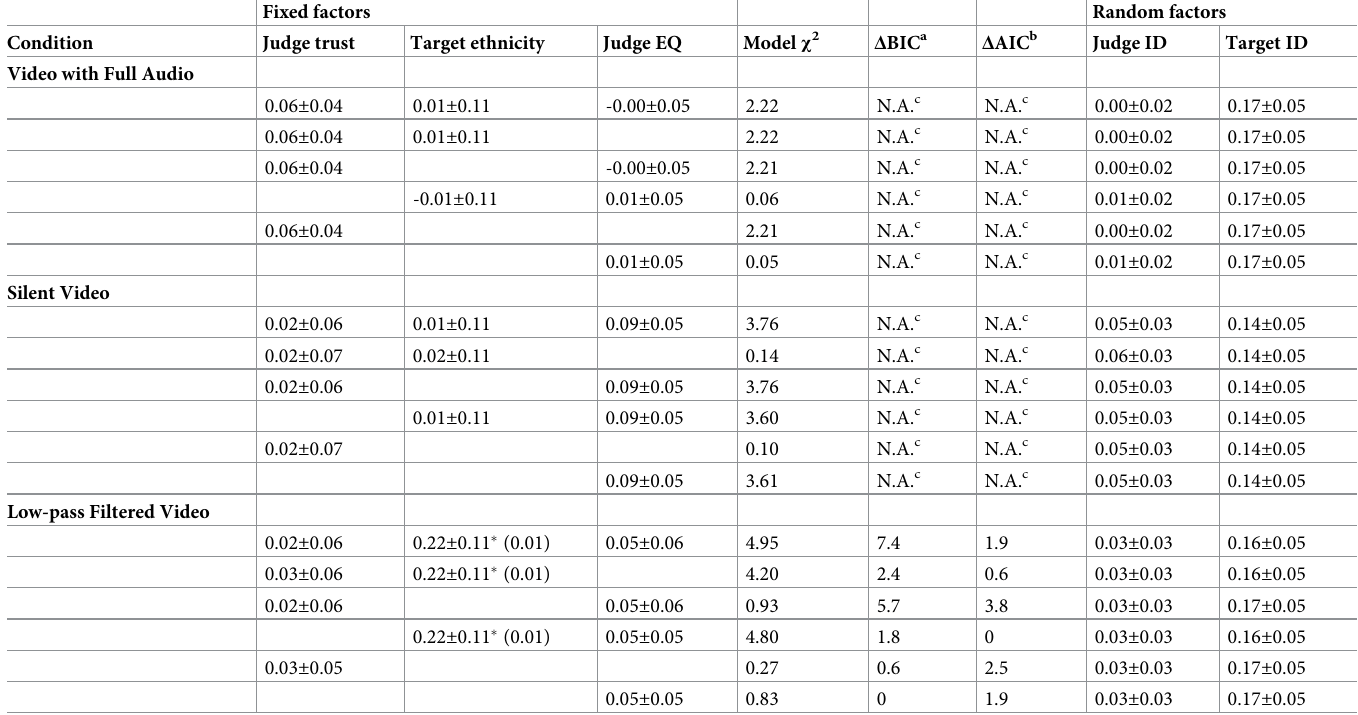
Table 9. Multilevel mixed regression models predicting absolute value of LORP-LSRP difference for total